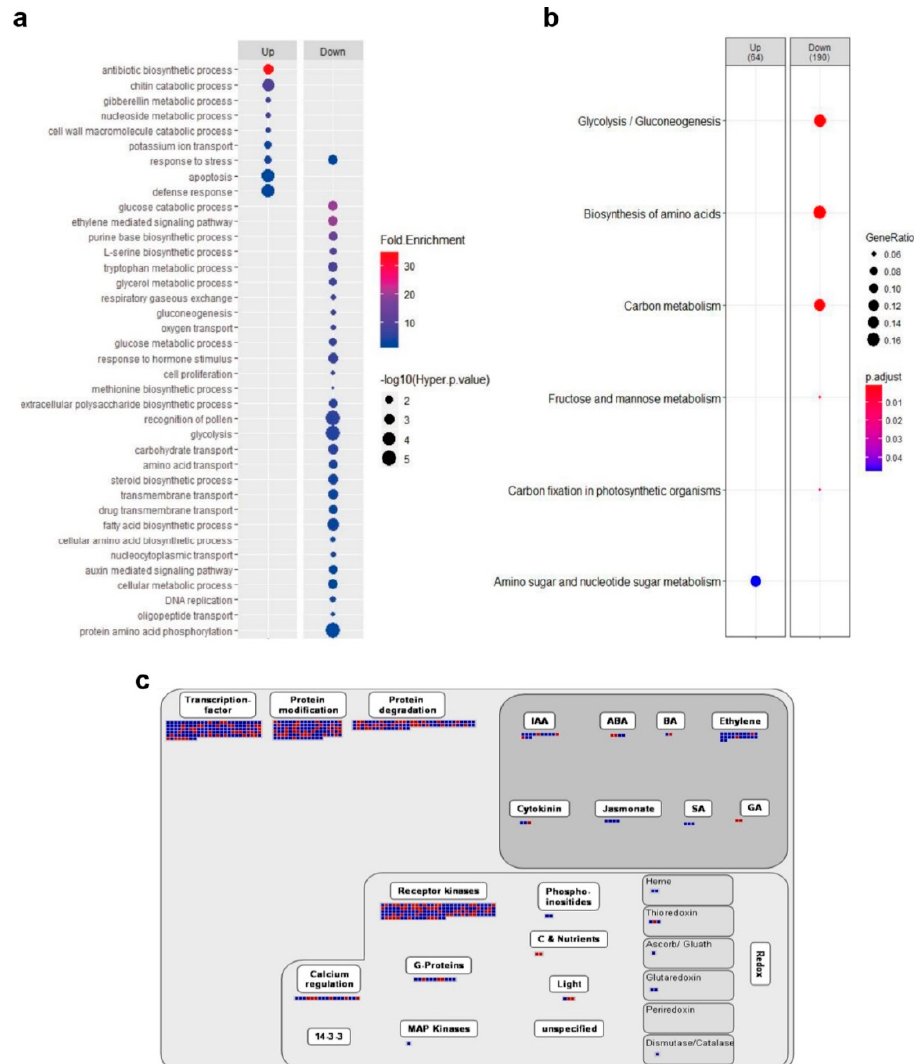
Figure 4. Transcriptome profile of the ossrlk mutant. ( a ) Gene ontology (GO) enrichment analysis of the 737 upregulated (Up) and 1303 downregulated (Down) differential expressed genes (DEGs) in ossrlk leaves compared to WT during dark-induced senescence (DIS). GO enrichment analysis results were visualized using the ggplot2 package. Gradual change from blue to red dots indicate gradually increased fold enrichment values. Dot size represents statistical significance ( − log 10 (hyper p -value)). ( b ) Kyoto Encyclopedia of Genes and Genomes (KEGG) enrichment analysis of DEGs. Dot size and color represent the ratio of selected genes to total genes in the pathway and the adjusted p -value, respectively. The numbers above the cluster indicate the DEG count for the selected KEGG pathways. ( c ) MapMan analysis of the DEGs. Red and blue squares indicate the members of upregulated and downregulated DEGs, respectively.